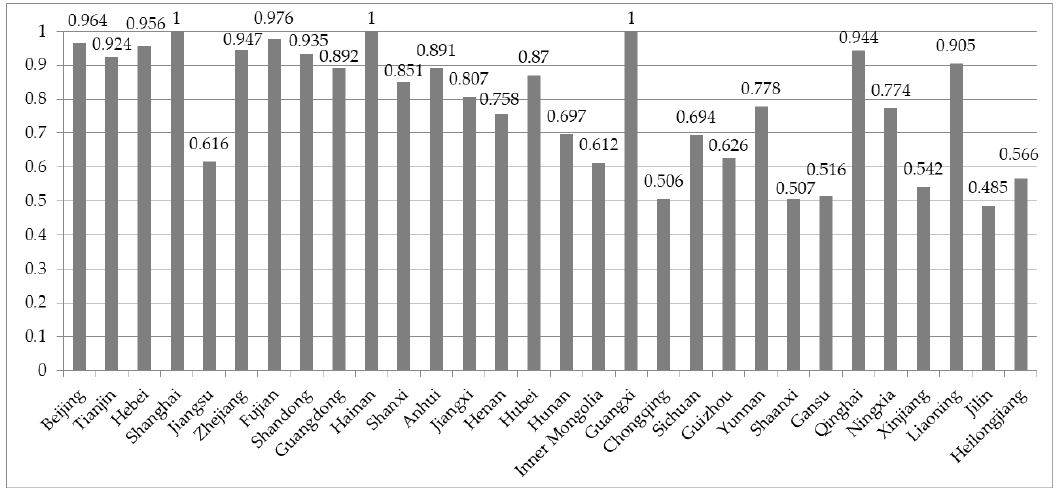
Figure 1. Mean values of TE in provincial-level administrative divisions, China (2007–2017).